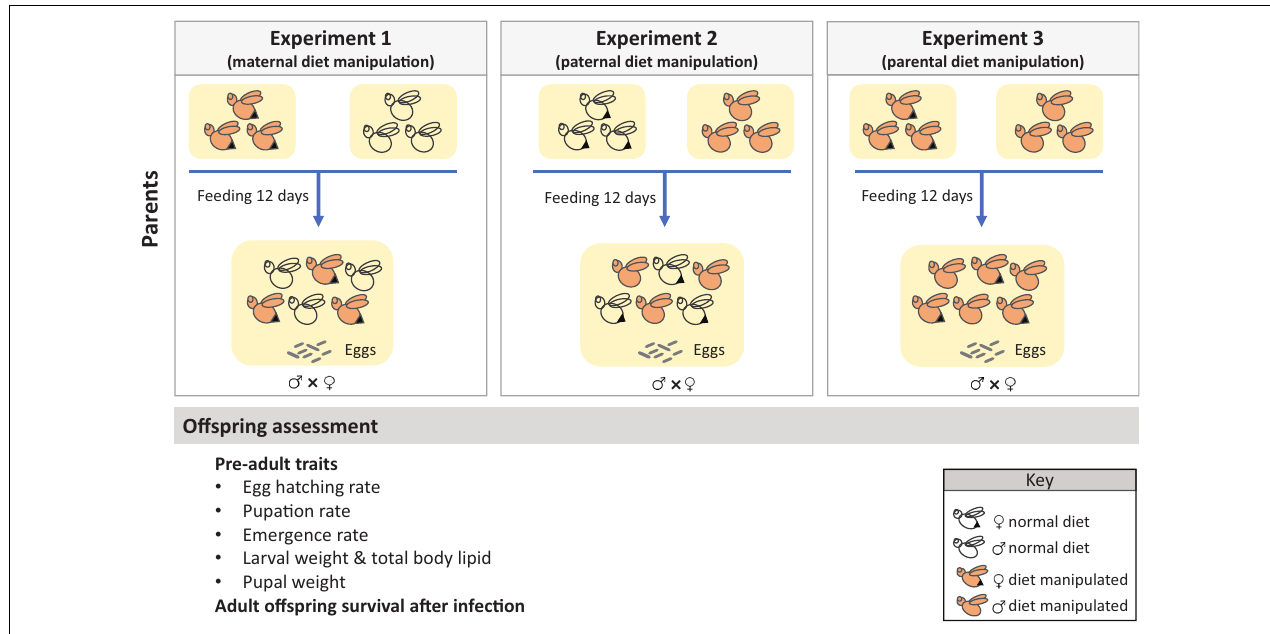
FIGURE 1 | Experimental set up of the three experiments of this study. Effects of maternal, paternal and parental manipulation of the diet were measured on several pre-adult and adult traits of the offspring.